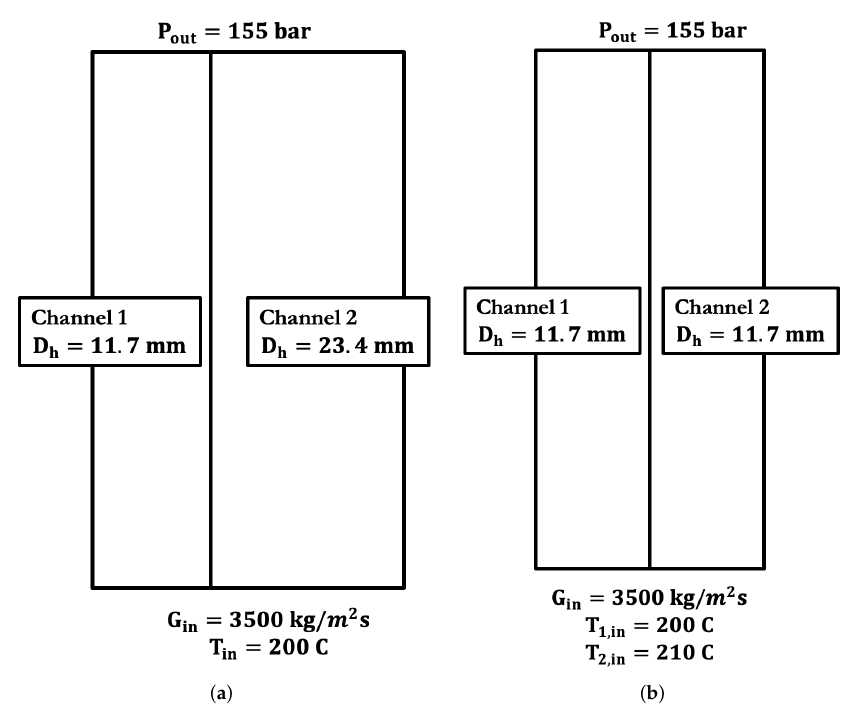
Figure 5. Verification Problems. ( a ) Two channel problem for friction model verification. ( b ) Two- channel problem for enthalpy mixing model